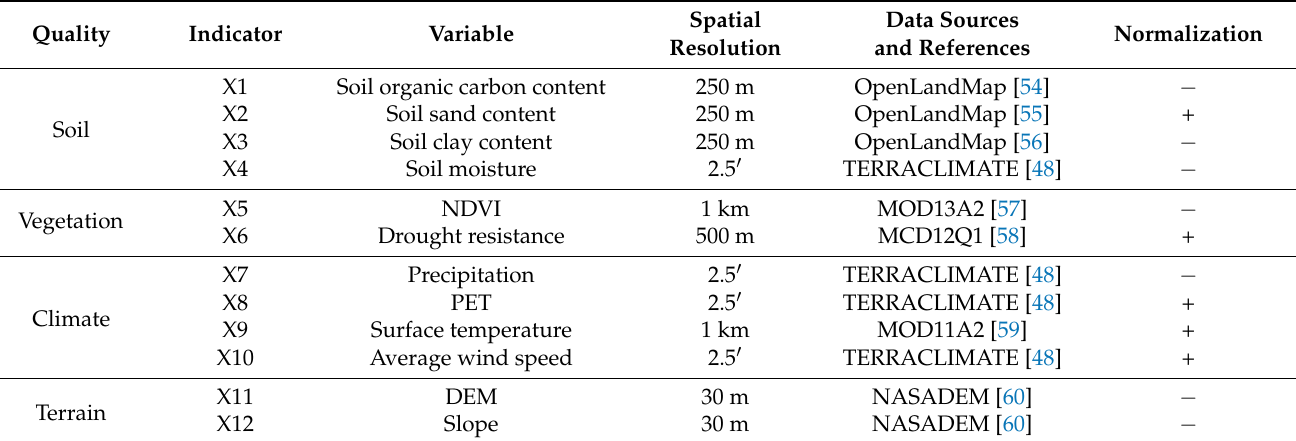
Table 1. Data sources.